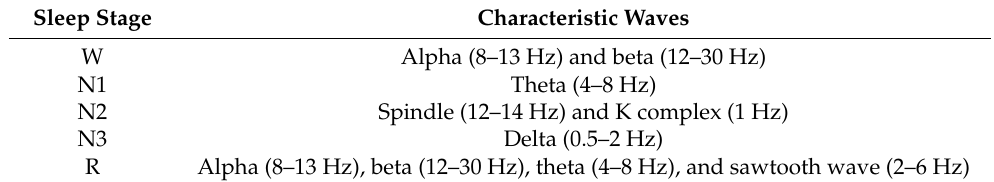
Table 1. Five sleep stages and their corresponding characteristic frequency. Sleep